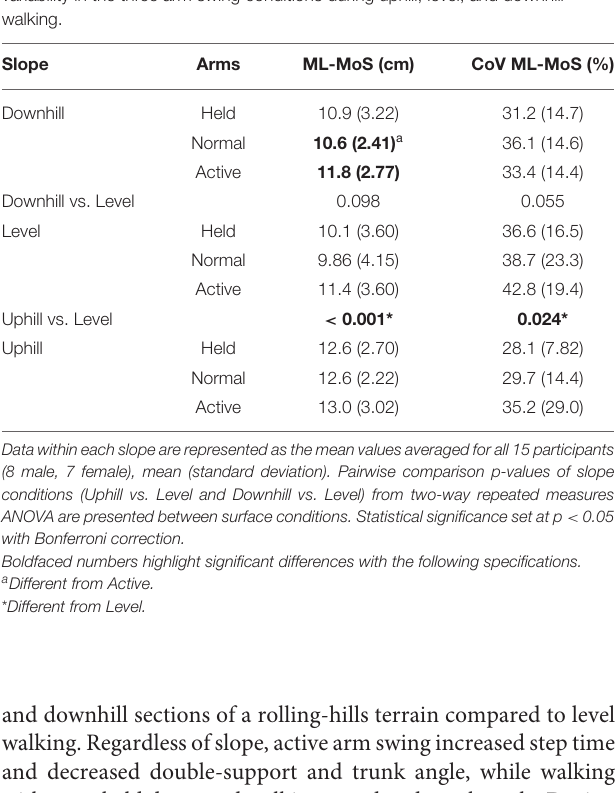
TABLE 4 | Comparison of mediolateral margin of stability and coefficient of variability in the three arm swing conditions during uphill, level, and downhill walking.